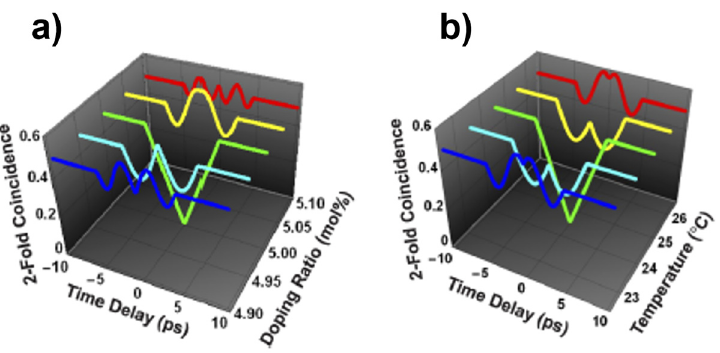
Figure 9. Simulated HOM interference patterns between the signal and idler photons from the same PPMgLN crystal at different doping ratio ( a ) and temperature ( b ) . Adapted and reproduced with permission from [57], copyright 2021.